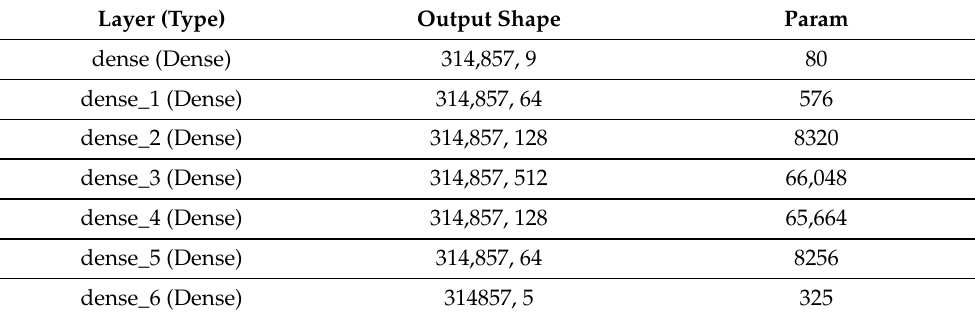
Table 5. Deep learning model summary.